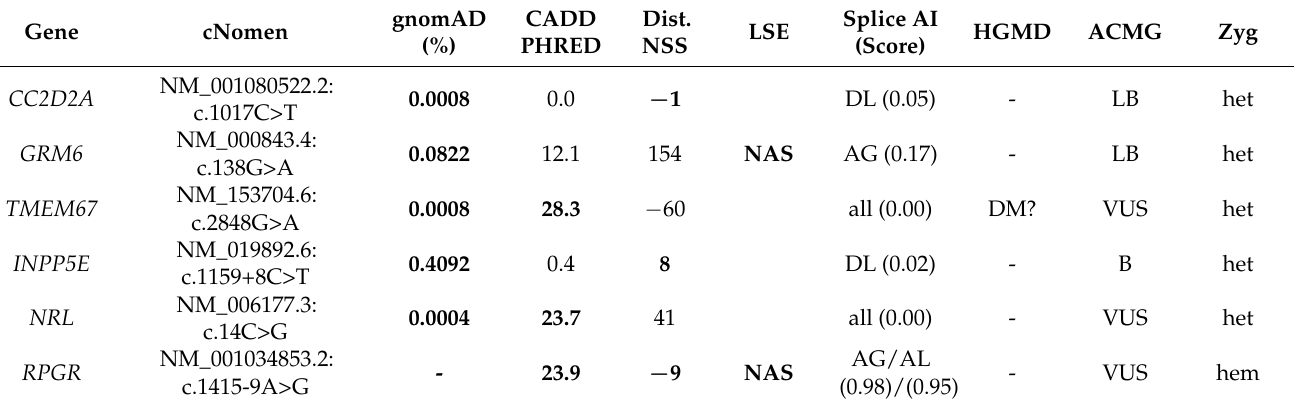
Table 1. Variants obtained after filtering WES data from the index patient. The selection criteria, in addition to the frequency, are highlighted in bold letters in the